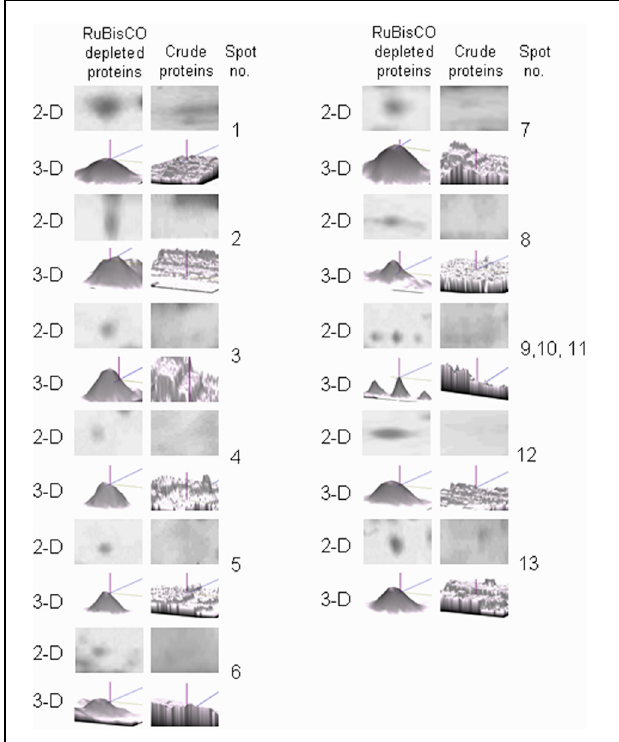
FIGURE 4 | Three-dimensional (3-D) view of unique protein spots in the RuBisCO depleted fractions generated using ImageMaster 2-D Platinum software (GE